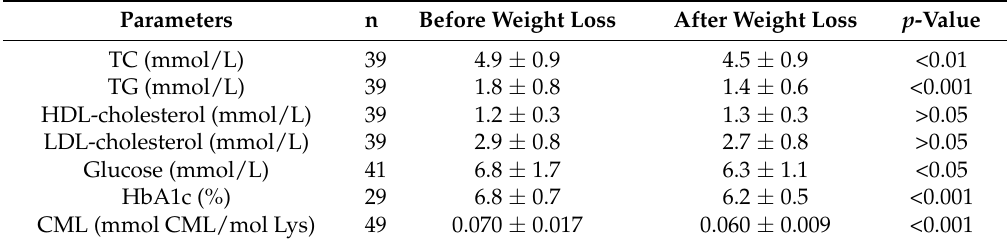
Table 1. The effect of weight loss on biochemical characteristics and CML